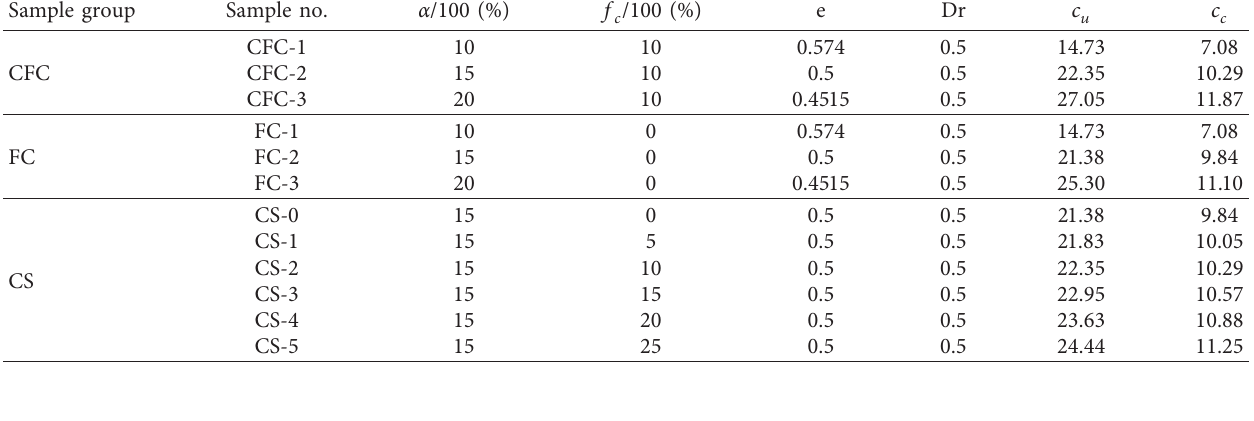
Table 1: Properties of soil used in testing.